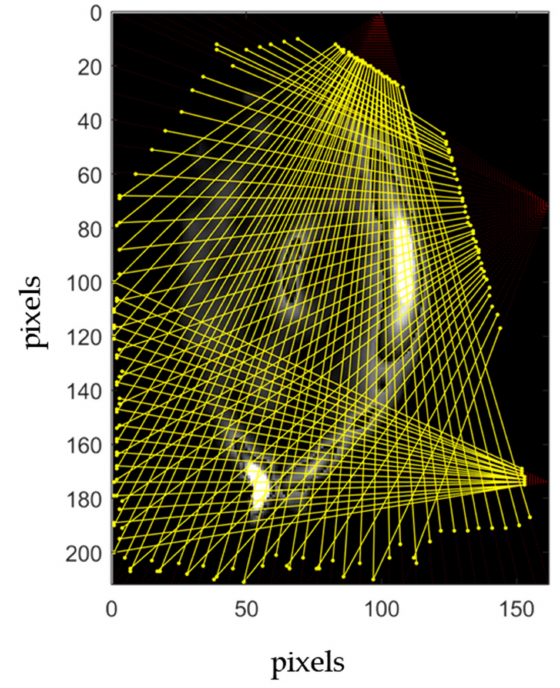
Figure 7. Simulated